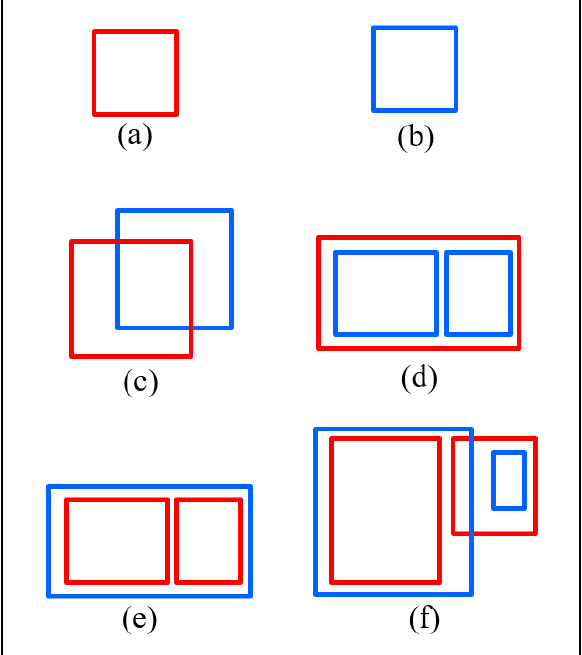
Figure 9. Six different cases for the non-overlapping and the overlapping situations. Inference building segments are denoted as blue and reference building polygons are denoted as red. (a) Omission building; (b) Commission building; (c) One-to-one correspondence; (d) Many-to-one correspondence; (e) One-to- many correspondence; (f) Many-to-many